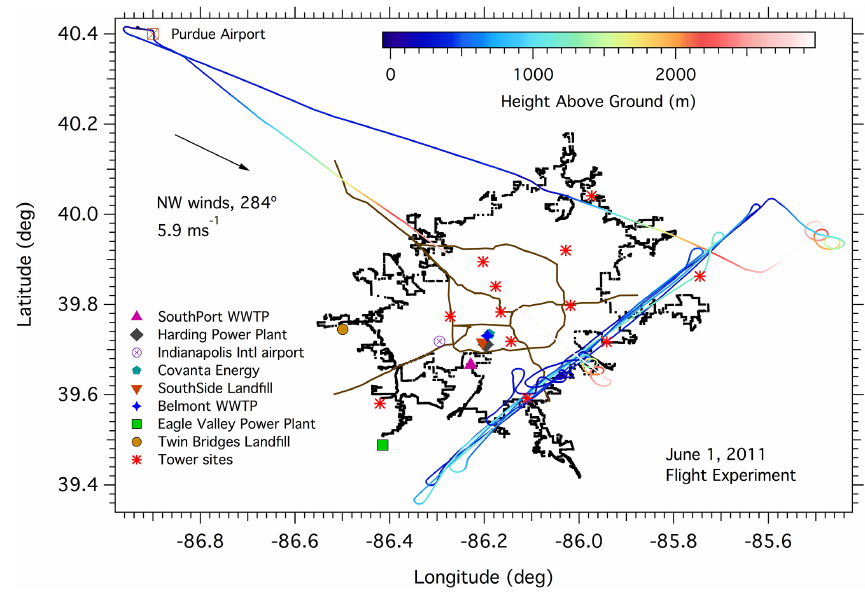
Figure 1. Flight path as a function of altitude downwind of Indianapolis, IN, USA on 1 June 2011. Mean winds were from the northwest at ∼ 6ms − 1 . Also shown are the locations of CO 2 and CH 4 sources within and around the city limits such as power plants (Harding Street and Eagle Valley power generating facilities), landfills, incineration plant (Covanta Energy), and wastewater treatment plants (Belmont WWTP and Southport WWTP). The brown outline represents the major highways inside the